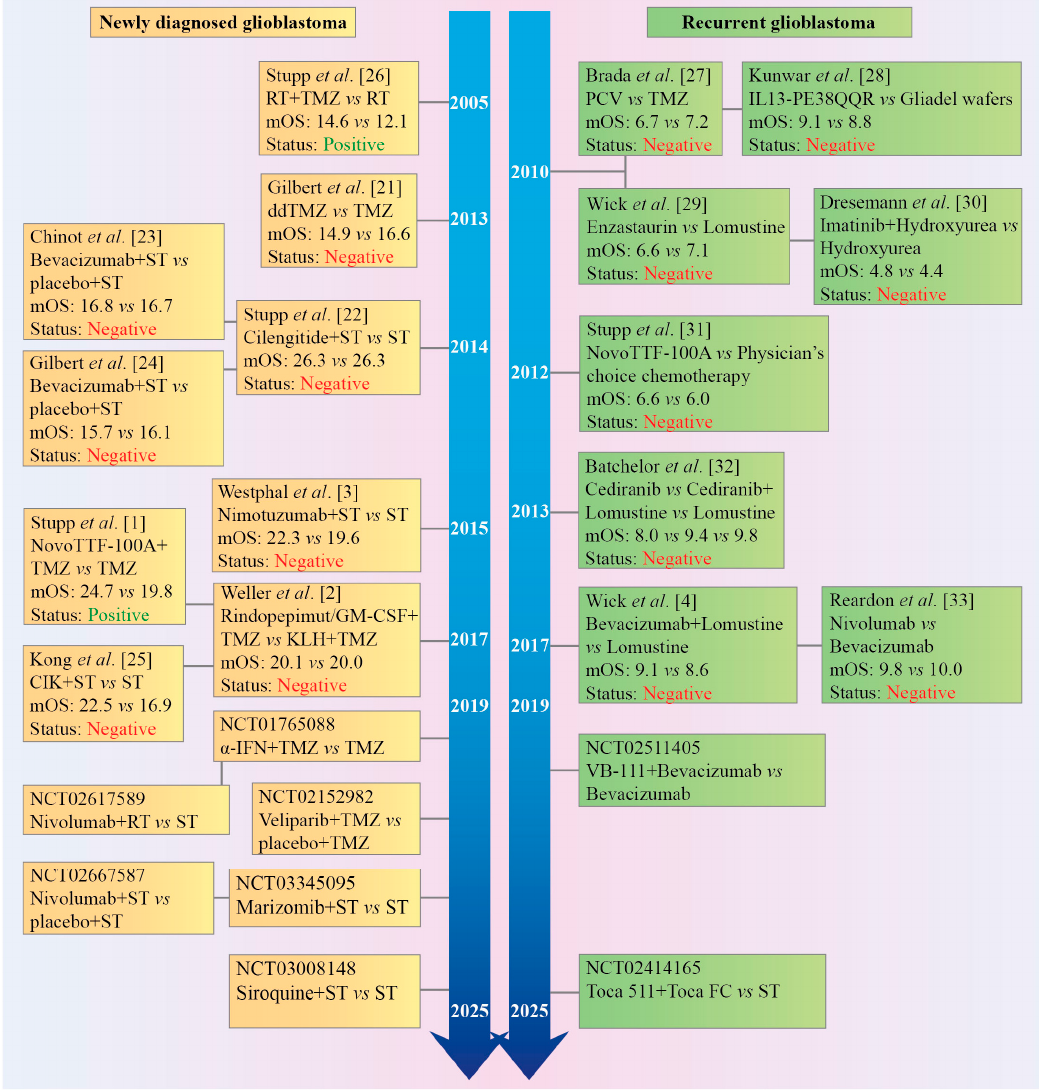
Figure 1. Timeline of phase III clinical trials in patients with newly diagnosed or recurrent glioblastoma. Almost all trials have been negative and failed to predict positive outcomes of the preceding phase II trials. α -IFN: interferon-alpha; Bevacizumab: anti-vascular endothelial growth factor (VEGF) antibody; Cediranib: an inhibitor of VEGF receptor; CIK: autologous cytokine-induced killer cells; Enzastaurin: an inhibitor of protein kinase C β (PKC β , as well as PKC α , PKC γ , and PKC ε at higher concentrations); IL13-PE38QQR, also known as Cintredekin besudotox: a recombinant chimeric cytotoxin composed of human interleukin 13 (IL-13) fused to a truncated, mutated form of Pseudomonas aeruginosa exotoxin A (PE38QQR); Marizomib: an irreversible proteasome inhibitor;